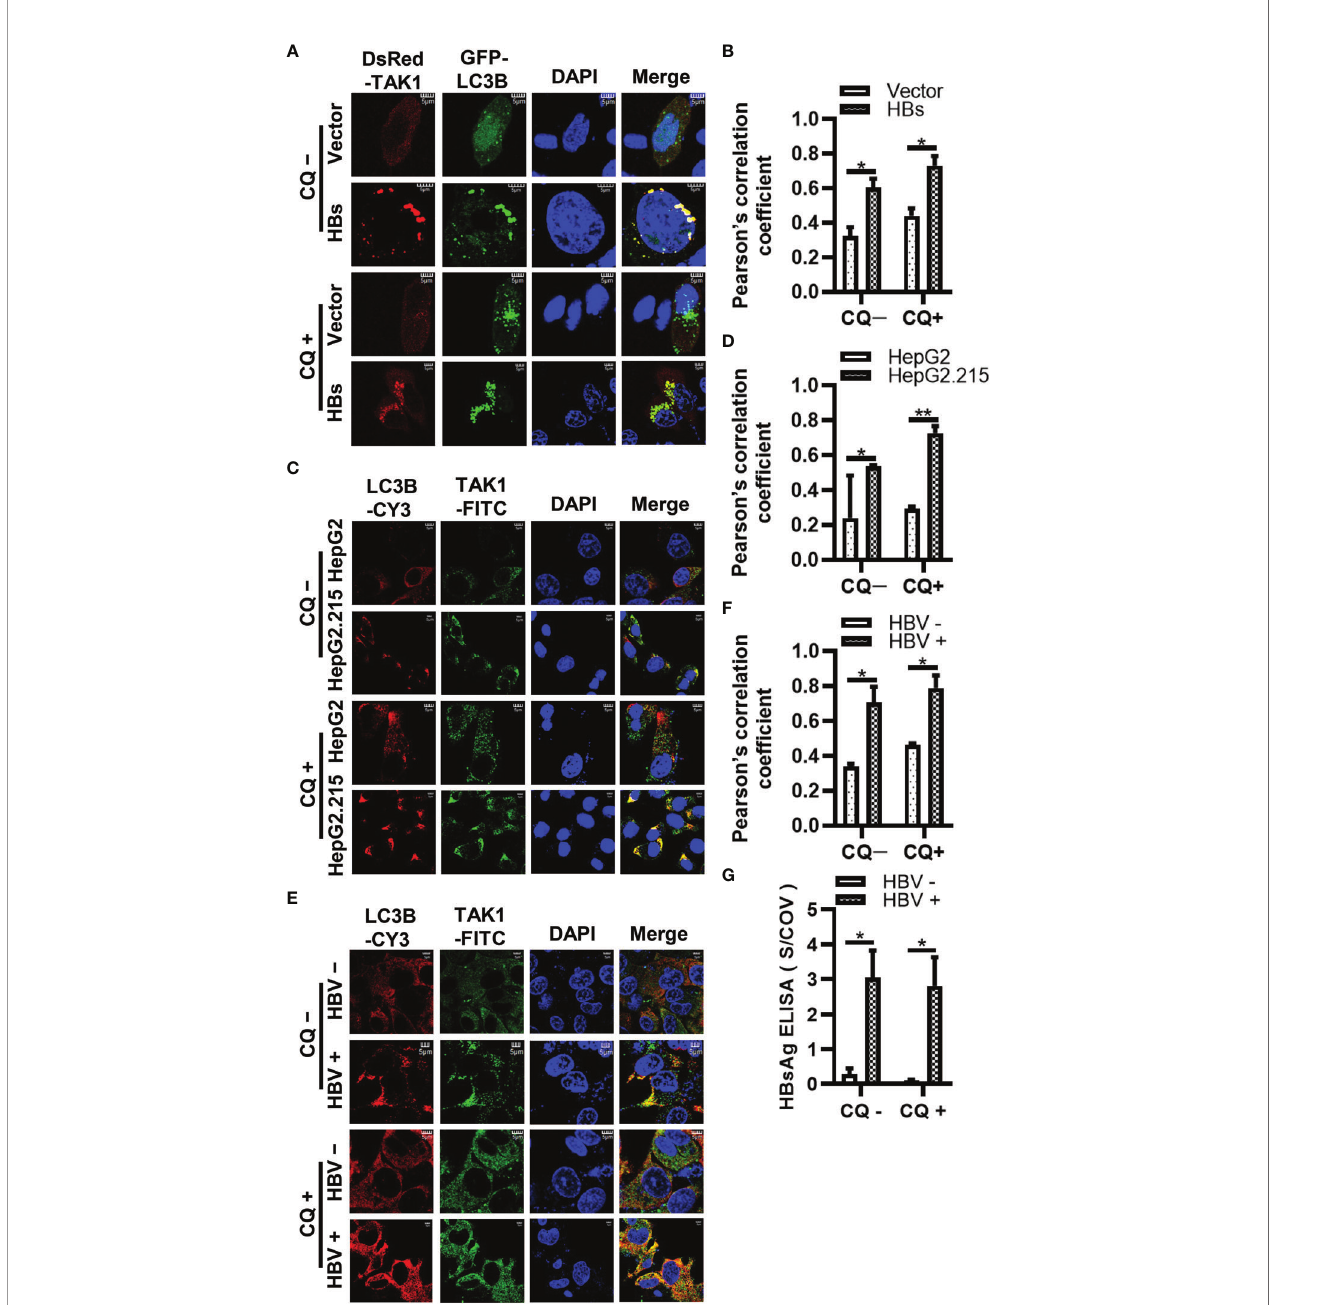
FIGURE 6 | The colocalization of TAK1 and LC3B in the presence of HBsAg is increased upon CQ treatment. (A) DsRed-TAK1, GFP-LC3B were co-transfected into HepG2 cells with HBs expression plasmids (3×Flag-HBsAg) or empty vector for 24 h; (C) HepG2 and HepG2.215 cells were plated on collagen incubated in 14- mm confocal dishes for 24 h; (E) HepG2-hNTCP cells were cultured in collagen-coated 14-mm confocal dishes with primary hepatocytes maintenance medium (PMM) for 6 h, infected with HBV for 4 days; Then treated with or without CQ (10 m M) for 24 h. LC3B were stained Cy3 goat anti-mouse IgG (H+L) and TAK1 were stained with FITC goat anti-rabbit IgG (H+L). The nuclei were stained with DAPI before observation using confocal microscopy. Scale bar = 5 m m. (B, D, F) We assessed the level of colocalization by Pearson ’ s correlation coef fi cient through using Image J. (G) The supernatant of HepG2-hNTCP on 5 days after HBV infection were collected for HBsAg ELISA analysis. The graphs show the means ± SD, n = 3 (**P < 0.01; *P <